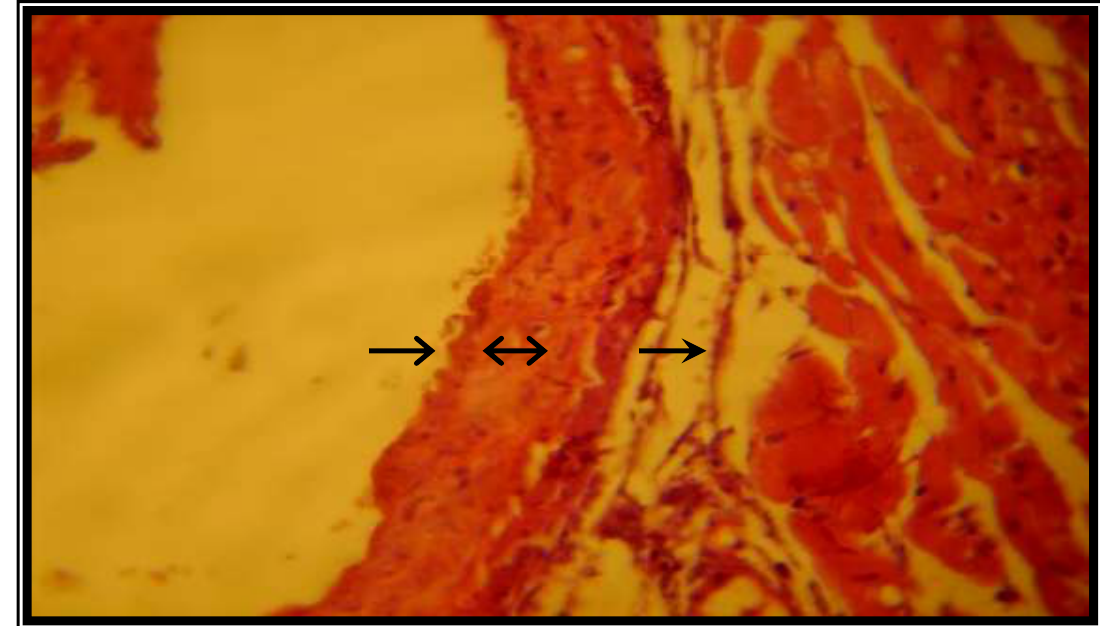
pulmonary Artery ( ) intima, ( ) muscularis,( ) advantia H & E